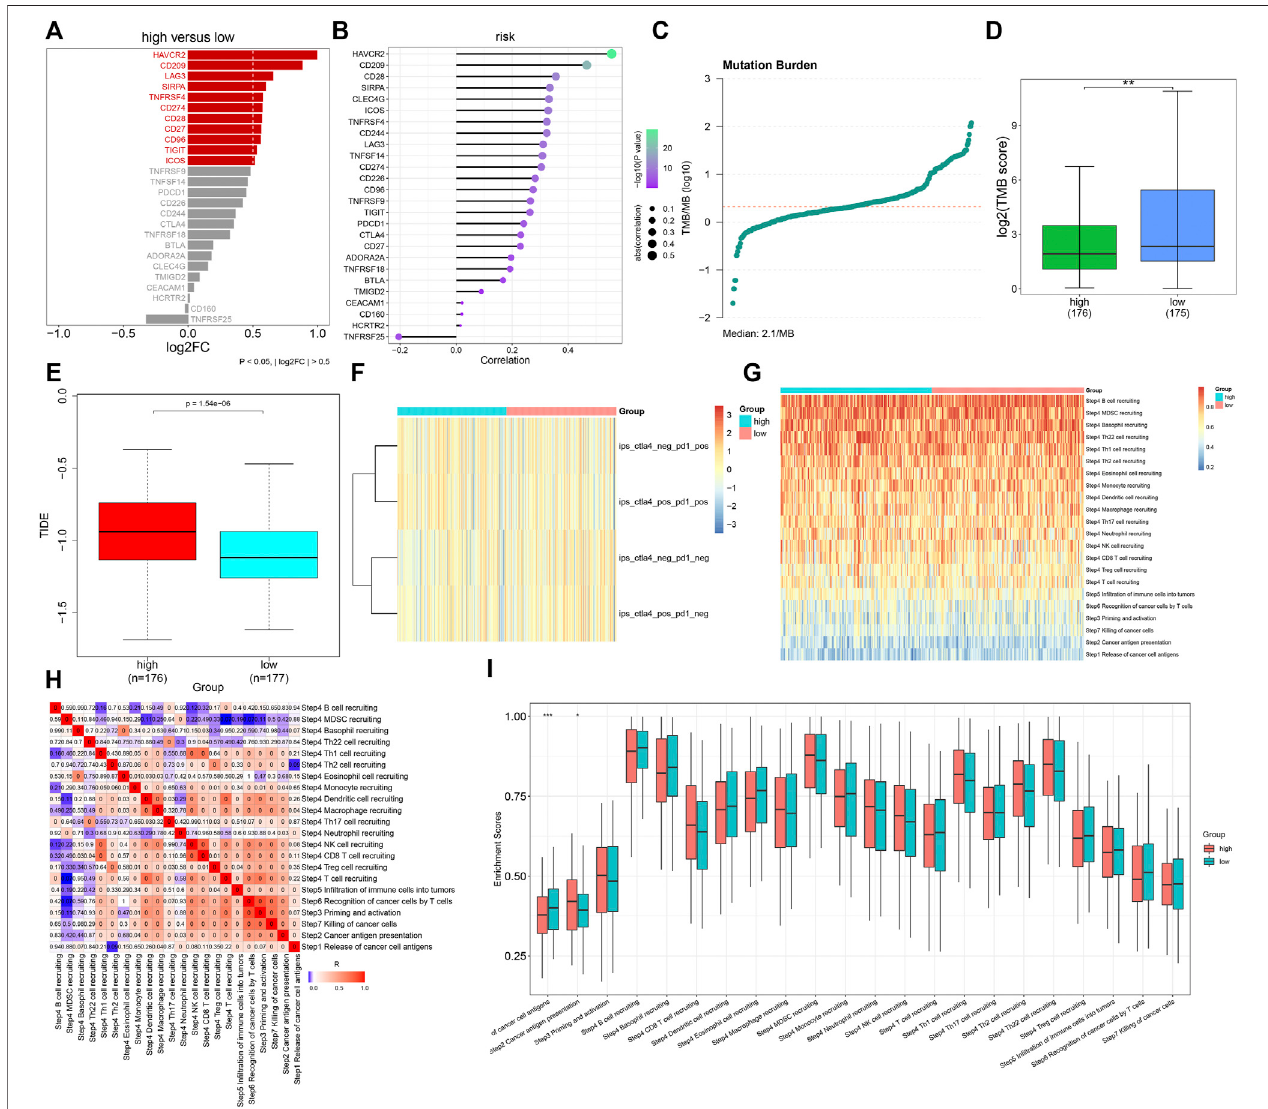
FIGURE 8 | Association of the TNF α -derived gene signature with immune response in GC. (A) Comparing the expressions of immune checkpoint molecules between groups. (B) Associations of immune checkpoints with the TNF α -derived risk score across GC specimens. (C) Distribution of TMB scores among GC tissues. (D) Comparison of the TMB score between subgroups. ** p < 0.01. (E) Comparison of the TIDE score between two groups. (F) Distribution of IPS scores in two subgroups. (G) Heatmap depicting the activities ofthe cancer immunity cycle across GCspecimens. (H) Associations of all steps within the cancer immunity cycle across GC specimens. (I) Differences in the activities of the cancer immunity cycle between high- and low-risk groups. * p < 0.05; *** p < 0.001.